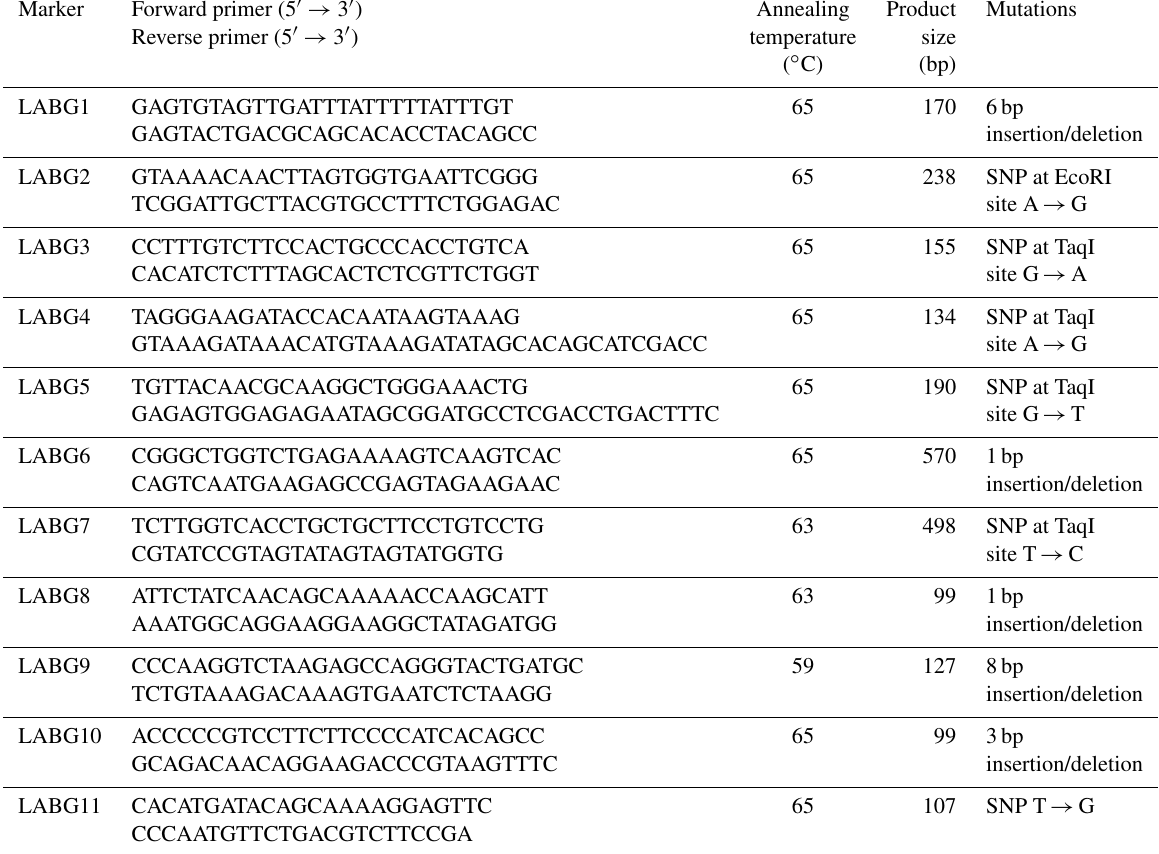
Table 2. Marker information for polymerase-chain-reaction–restriction-fragment-polymorphism (PCR-AFLP). Marker Forward primer (5 (cid:48) → 3 (cid:48) ) Reverse primer (5 (cid:48) → 3 (cid:48)